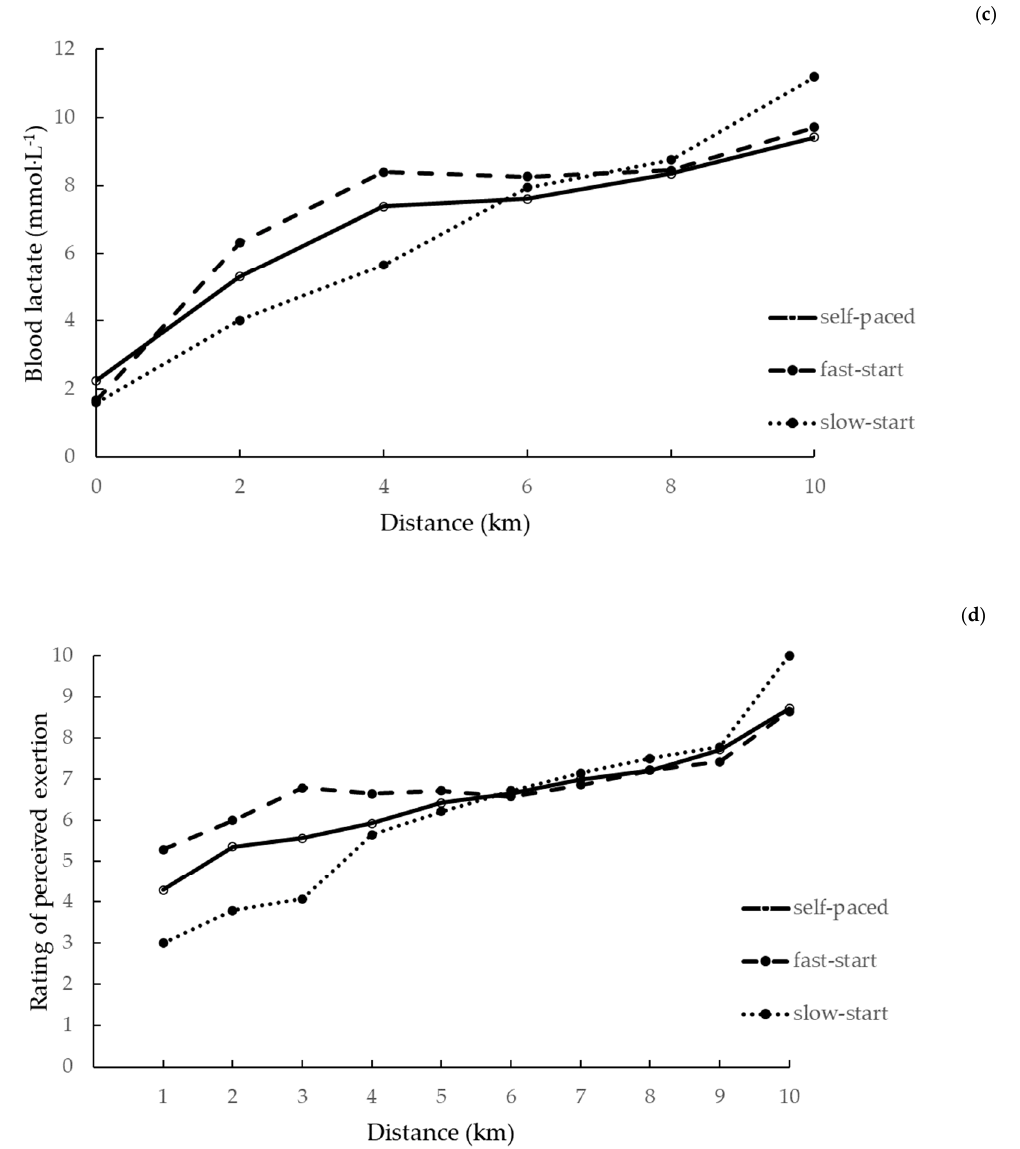
Figure 1. Power output ( a ), heart rate ( b ), blood lactate ( c ), and rating of perceived exertion ( d ) responses in relation to starting strategy.